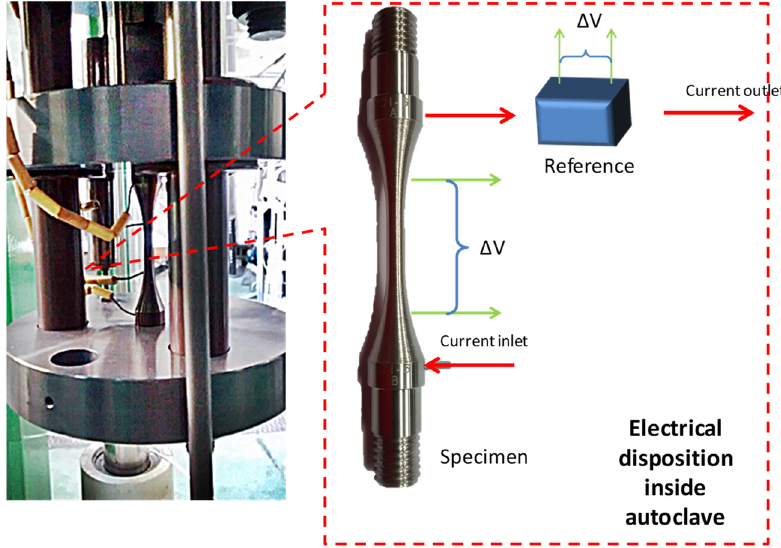
Figure 2. Experimental setup and schematic of the DCPD measurement system.